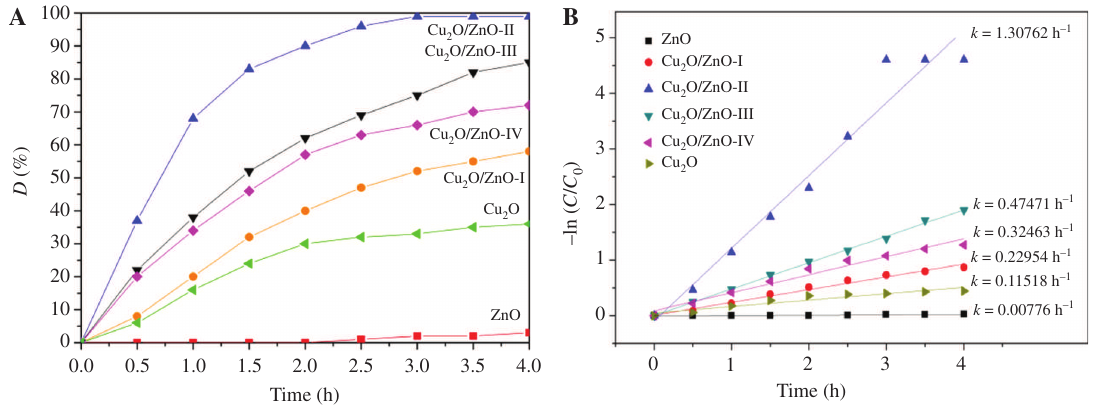
Figure 7: Photocatalytic activity of Cu 2 O/ZnO prepared with different Cu 2 O concentrations (A) and kinetic plot of MO degraded with